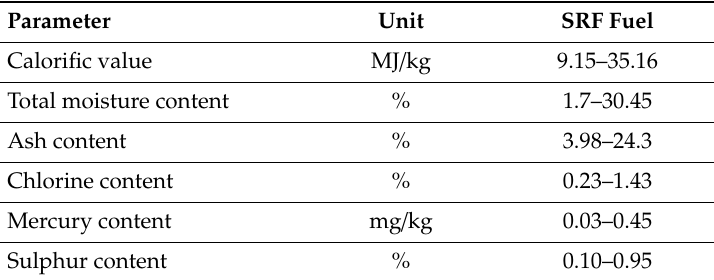
Table 1. Properties of solid recovered fuels (SRF) fuels